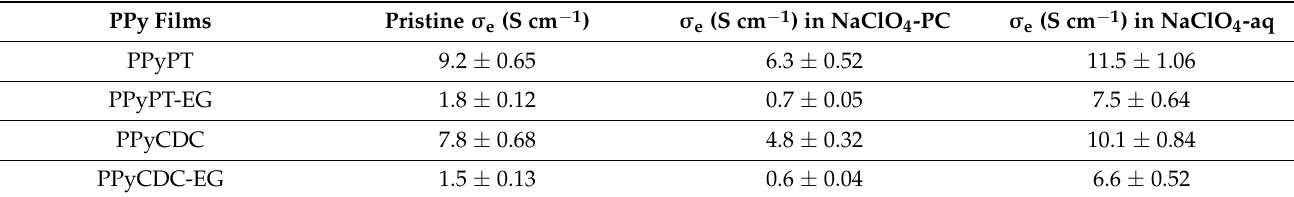
Table 1. Electronic surface conductivities σ e of films of type PPyPT, PPyPT-EG, PPyCDC and PPyCDC-EG in pristine condition (direct after electropolymerization) and after